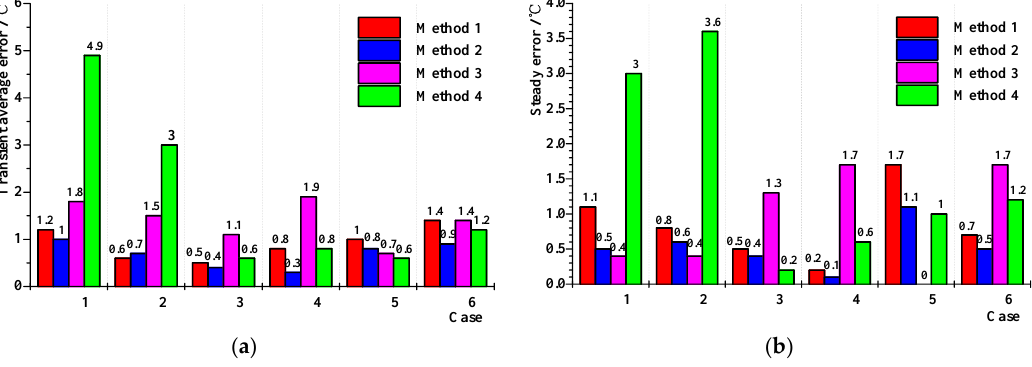
Figure 14. Conductor temperature errors using tested thermal resistances: ( a ) transient and ( b ) steady.